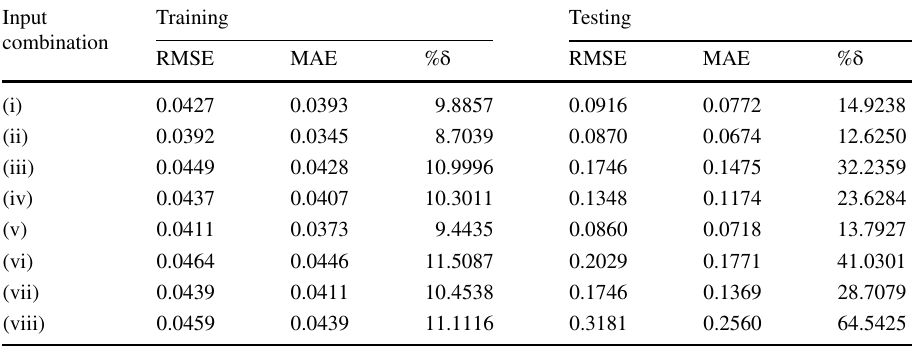
Table 4 Statistical parameters for selection of the more appropriate input